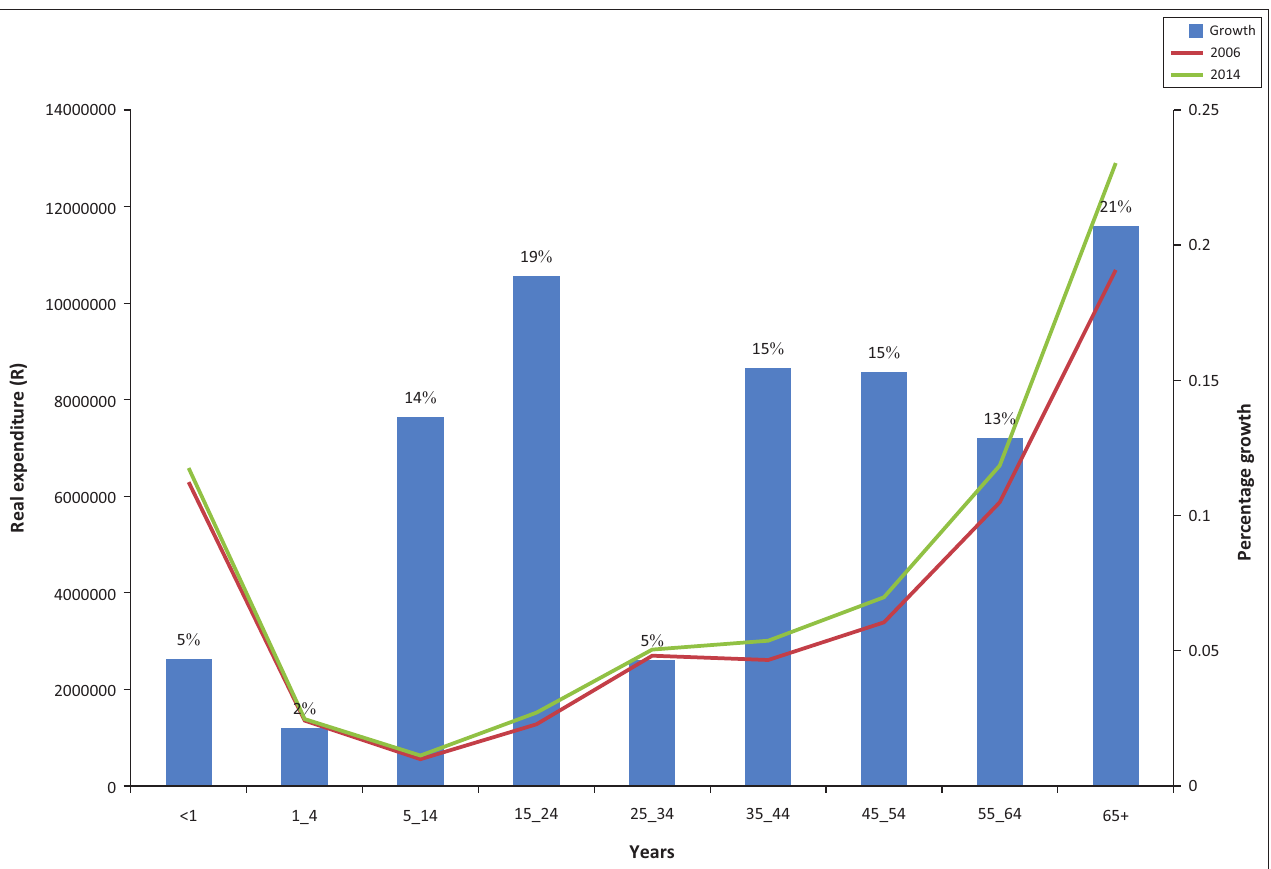
FIGURE 8: Cumulative real expenditure (Rands) growth per age group, per 1000 beneficiaries; 2006 and 2014.